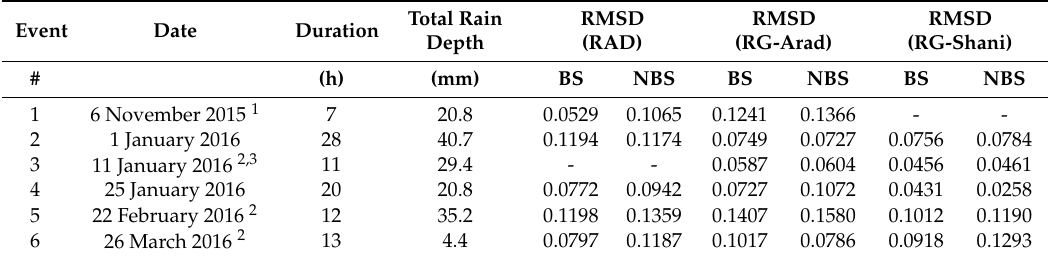
Table 1. Experimental results. The details of each rain event (averaged by the two available rain gauges), and the normalized Root Mean Square Error (RMSD) between the radar (RAD) and the Commercial Microwave Link (CML), and between the two Rain-Gauges (Arad and Shani) and the CML are